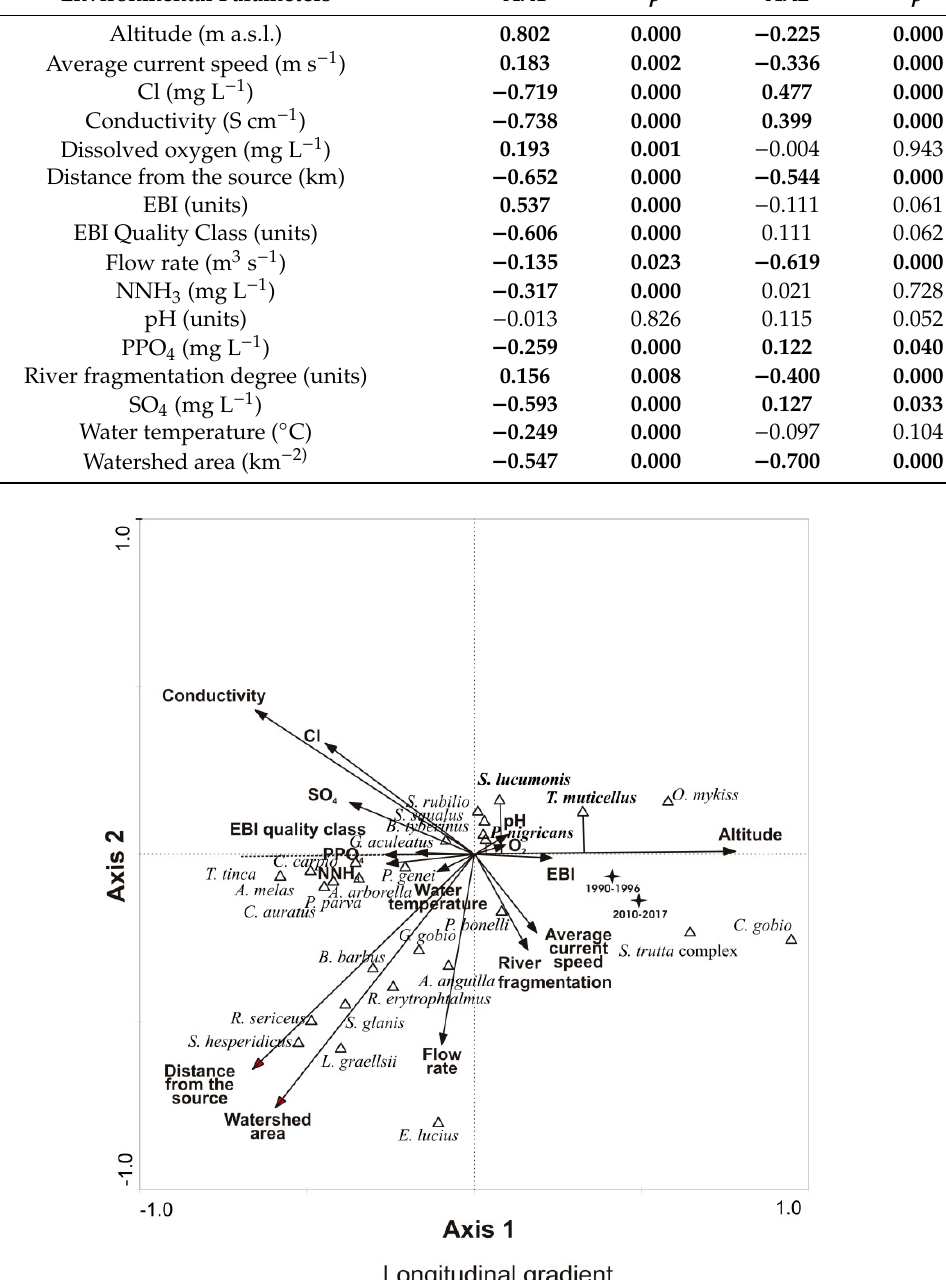
Table 1. Canonical and correlation coefficients of environmental variables with axis. p < 0.05 is in bold.